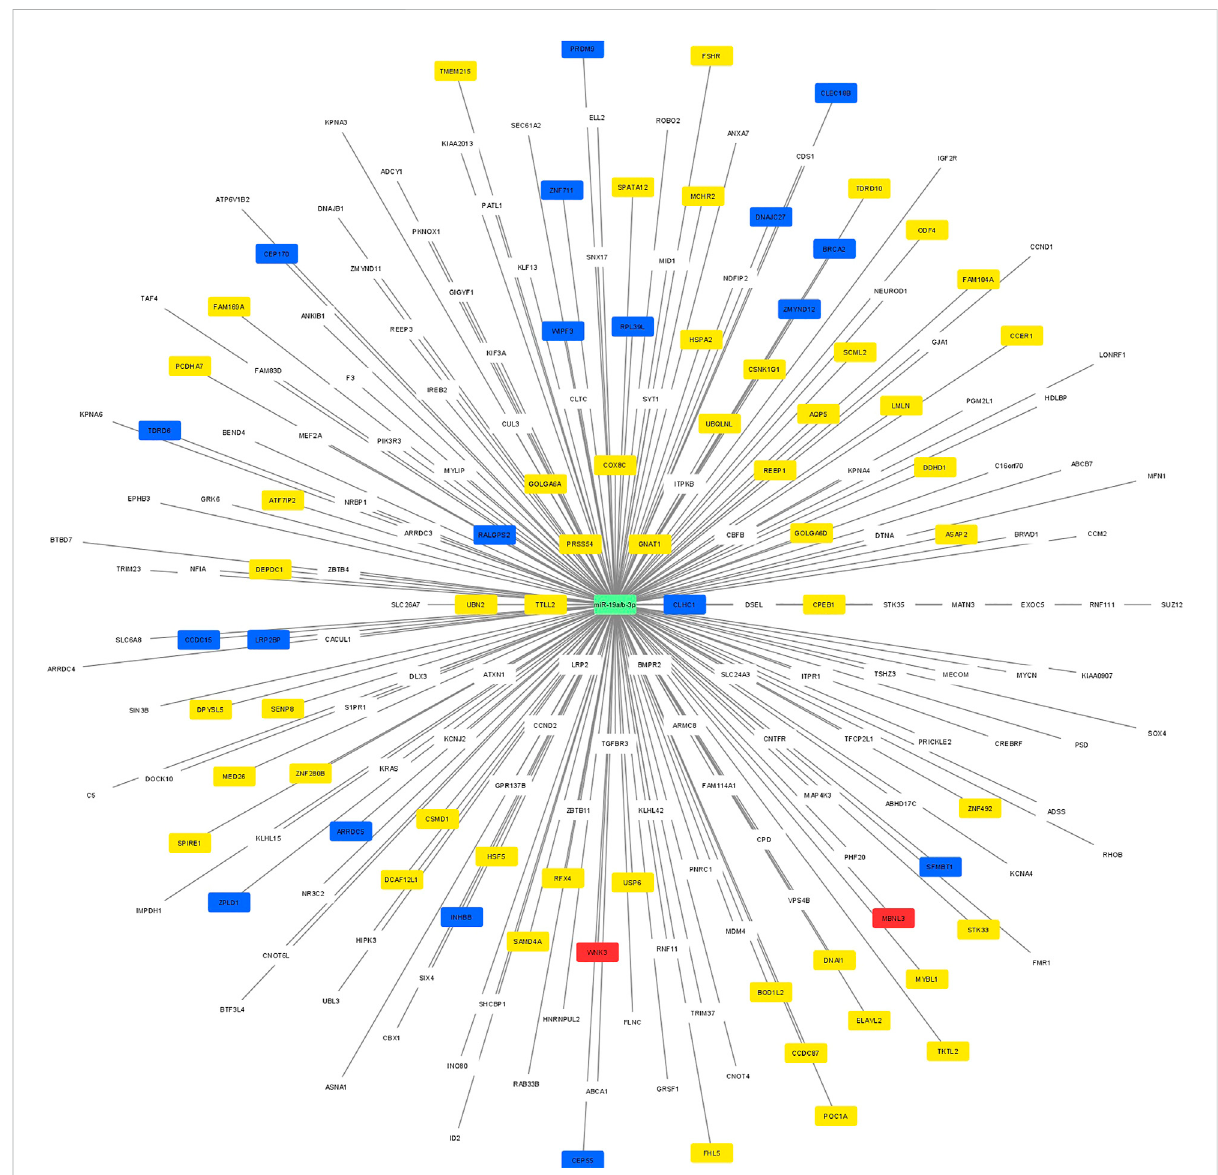
FIGURE 3 A regulatory network between the potential target predicted genes and the 74 genes which were included in the RT-qPCR. The yellow nodes showed the signi fi cantly lower expressed genes, the red nodes showed the signi fi cantly higher expressed genes, and the blue nodes represent the non-signi fi cant genes, as resulted from